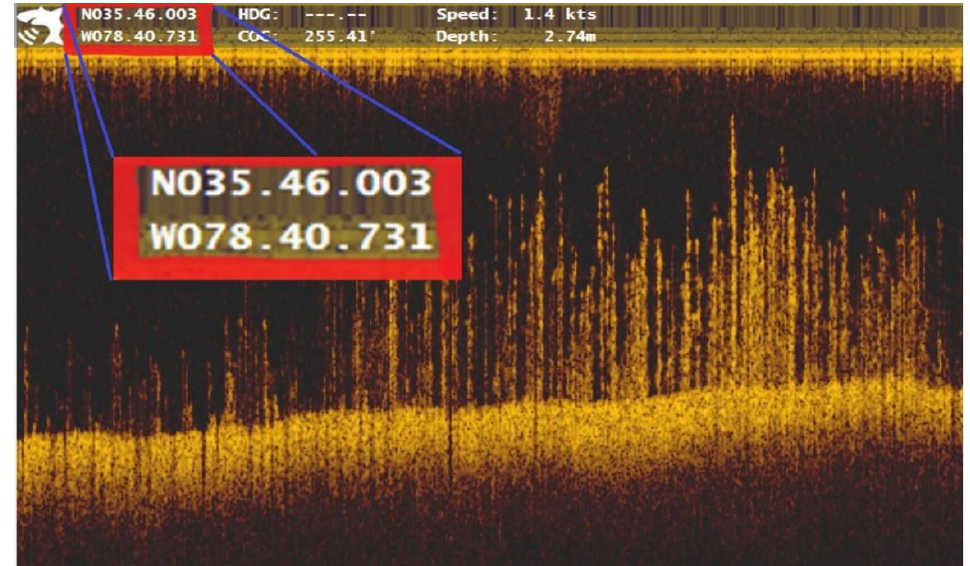
Figure 12. Geo- tagged DownScan™ image with GPS coordinates in the top left corner. Figure 12. Geo-tagged DownScan ™ image with GPS coordinates in the top left